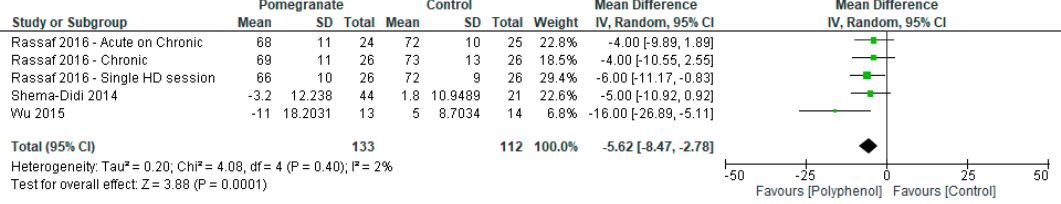
Figure 3. Forest plot of polyphenol-rich interventions on diastolic blood pressure.